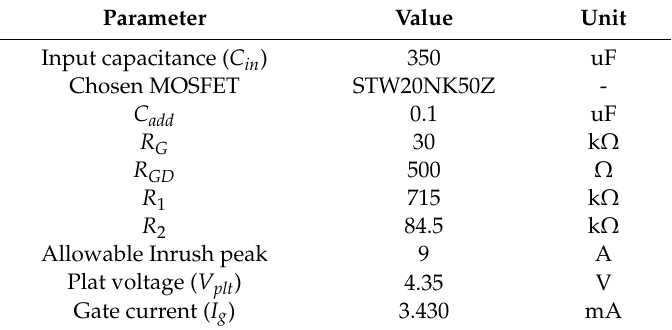
Table 1. Design Results for Active Inrush Current Control Circuit.